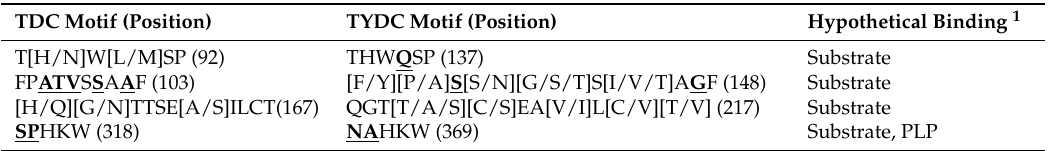
Table 2. Potentially discriminative motifs resulting from alignments of plant TDC and TYDC sequences, respectively. Discriminative amino acids of each motif are reported in bold and underlined